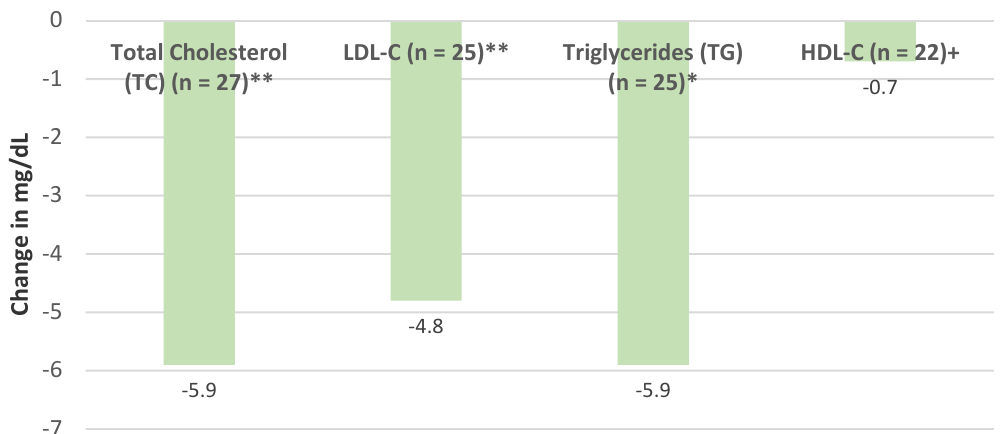
Figure 16. Meta-analysis on mean changes in blood lipids between almond and control interventions (** p ≤ 0.001, * p = 0.042, + p = 0.207)